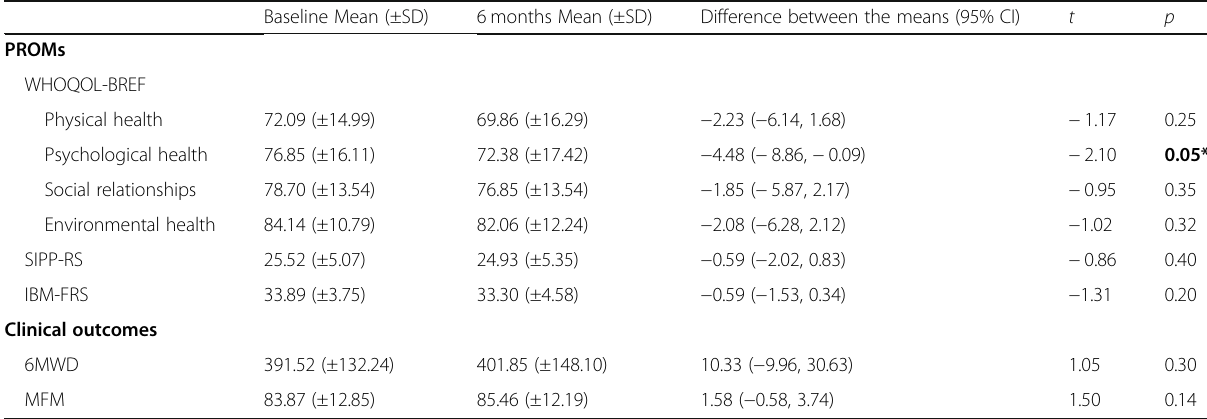
Table 3 Comparison between baseline and 6 months follow-up visit for PROMs and clinical outcomes